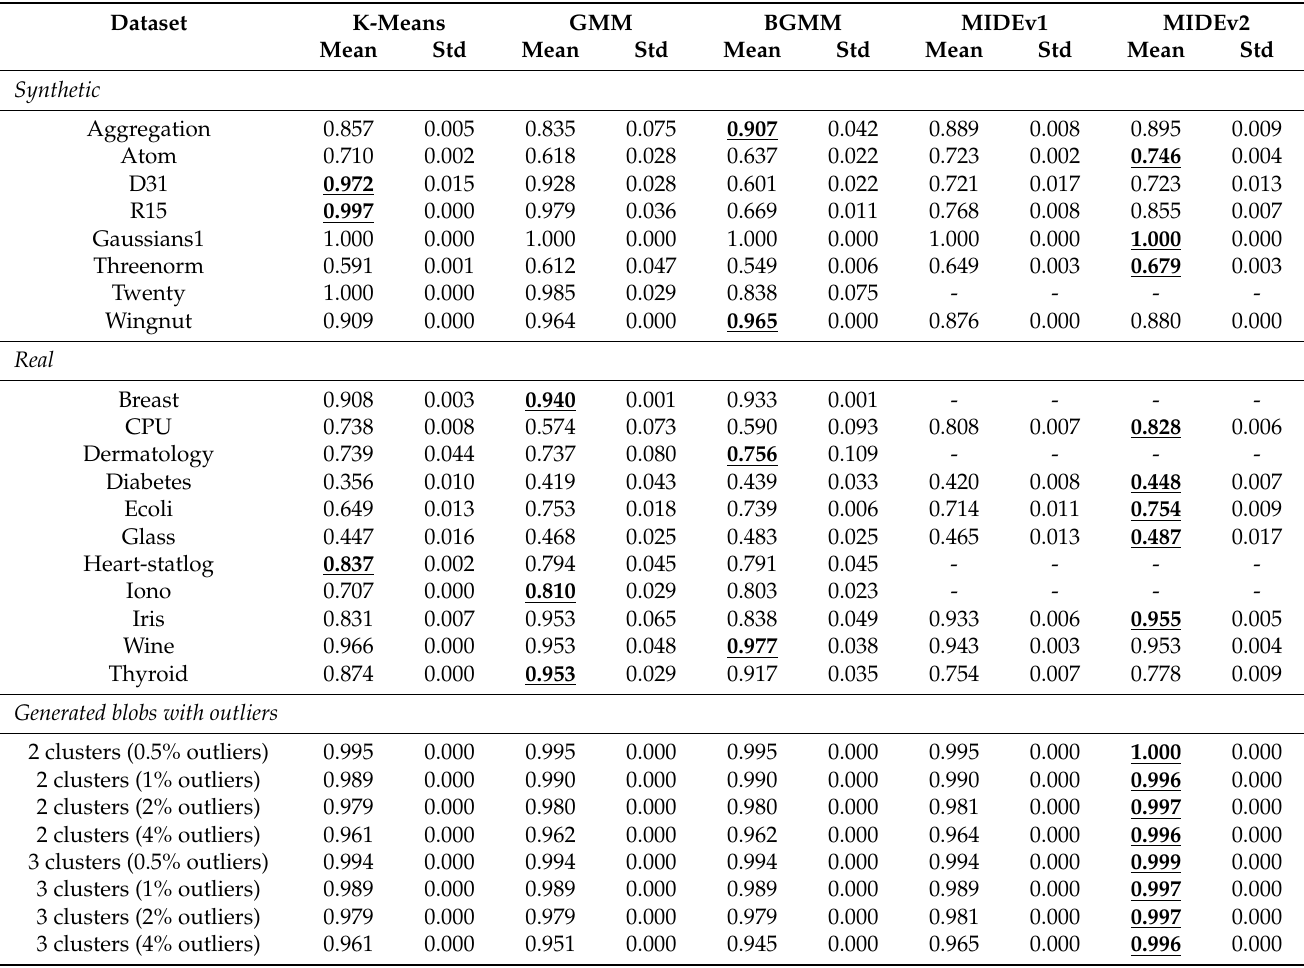
Table 2. Different models were comparative (means and standard deviation) based on the accuracy (ACC) for 10,000